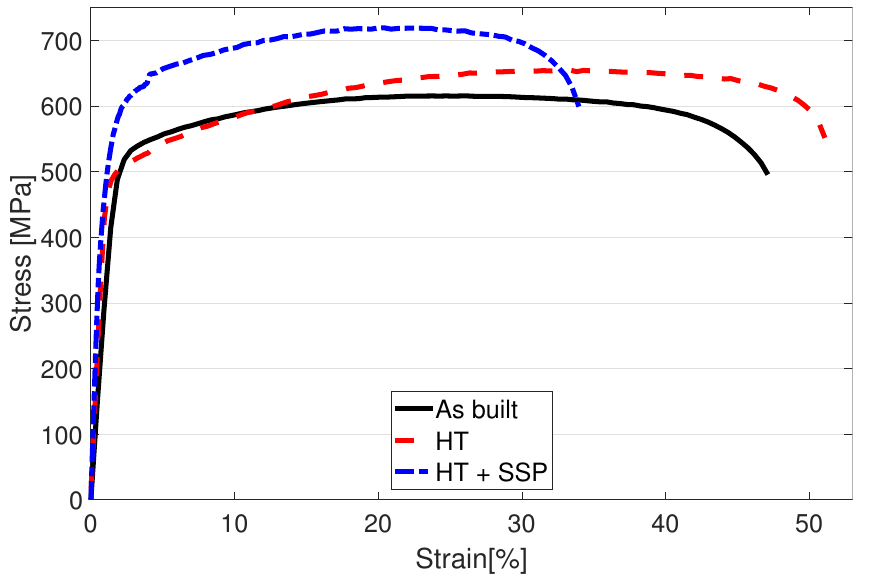
Figure 4. Tensile test results for the as built, heat treated and severe shot peened specimens of LPBF manufactured 316L steel. Table 2. Mechanical properties of the printed 316L structures: yield strength (YS) for proof stress of 0.2%, 0.5% and 1%, ultimate tensile strength (UTS) and elongation at